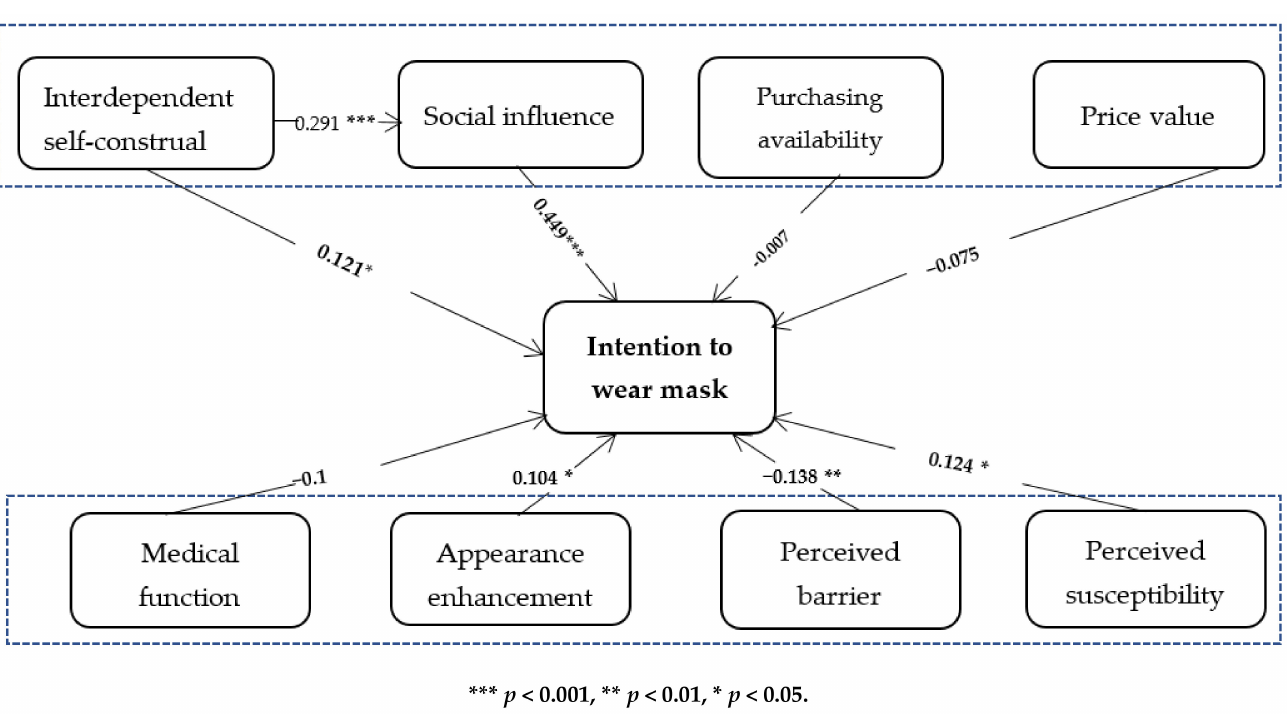
Figure 1. Overall regression